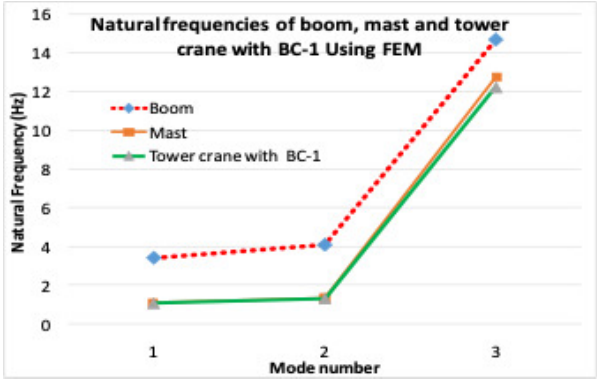
Figure 9. Comparison of natural frequencies of the boom, mast, and tower crane fort from the operator to remove the masts above the near- est bracing clamped to the building. In this novel approach, four-mast blocks are removed from the top of the mast